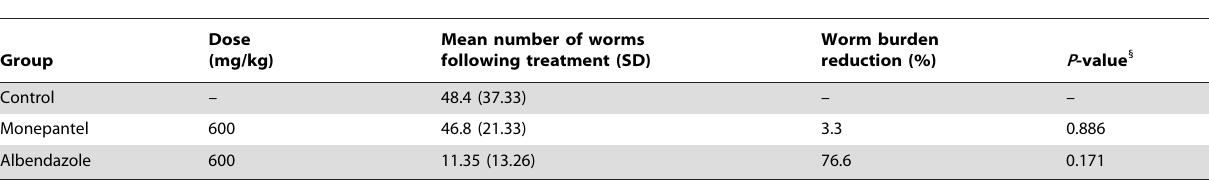
Table 6. Effects of monepantel and albendazole on A. suum in vivo .